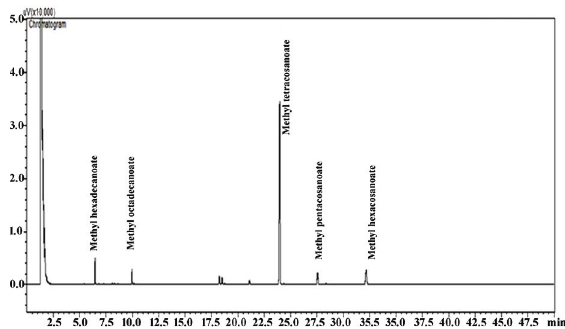
Figure 10 - GC analysis of methyl esthers from GIPLs fatty acids from epimastigotes of T. cruzi Silvio X10/1 strain.